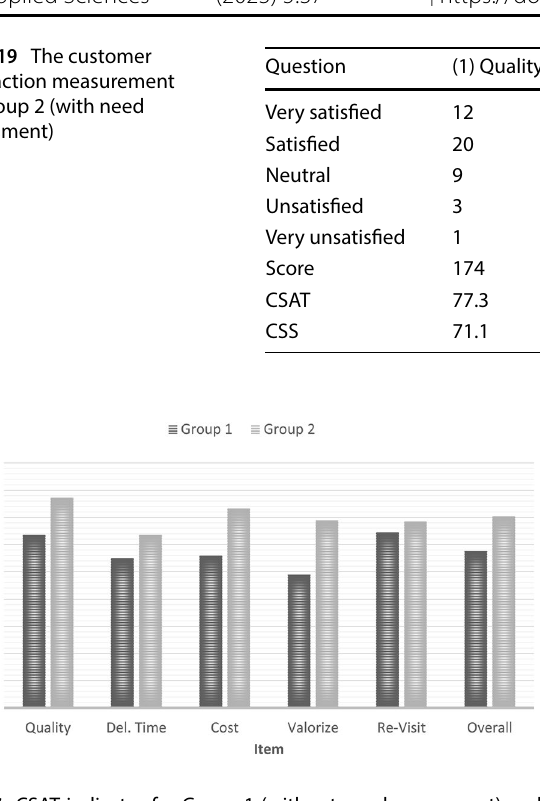
Fig. 17 CSAT indicator for Group 1 (without need assessment) and Group 2 (with need assessment) Table 20 NPS indicator for Groups 1, 2